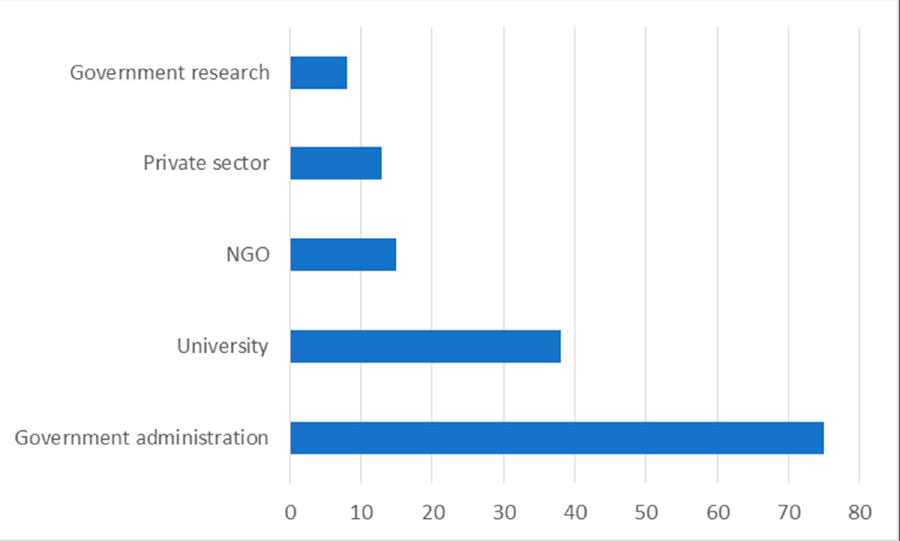
Figure 2. Professional background of APFNet Scholarship Program awardees (number of students). NGO—Non-governmental organization